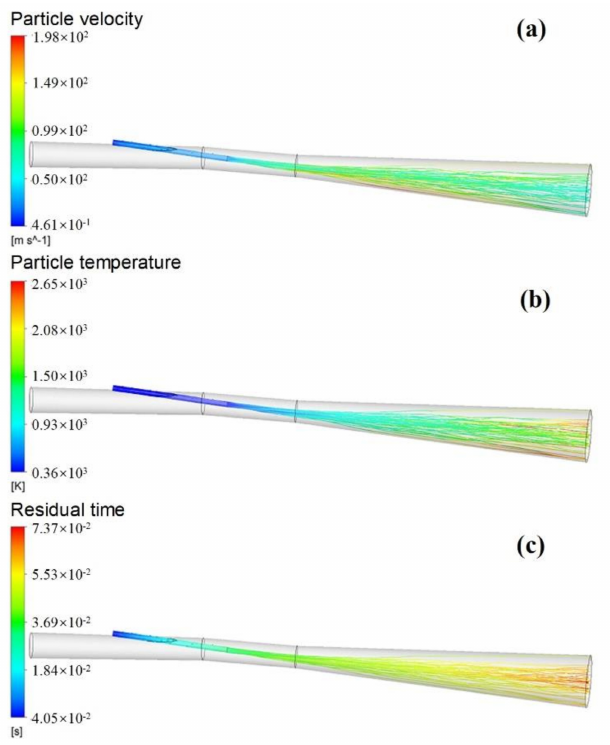
Figure 10. Velocity ( a ), temperature ( b ) and residual time ( c ) distribution of pulverized coal particles. To clarify the combustion of the blended coal in the raceway, the variation of the burnout of the pulverized coal particles during the movement process was calculated, as shown in Figure 11. It can be found that the low-temperature pulverized coal moves faster near the tip of the coal lance, and the combustion is not sufficient. The VM in the pulverized coal are gradually released with the increase of temperature, and more residual carbon participates in the oxidation and gasification reactions, resulting in a sharp increase in the burnout of the pulverized coal. Since the O 2 is consumed in the end of the raceway, the composition and temperature distribution of the gas tends to be uniform; the burnout of pulverized coal changes little and finally stabilizes at about